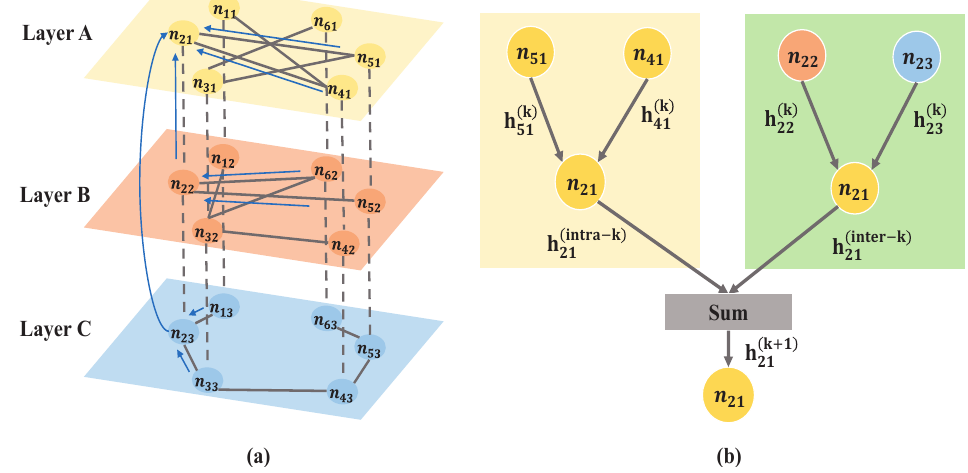
Figure 3. ( a ) Multi-layer networks. ( b ) Computation of multi-layer node embeddings.